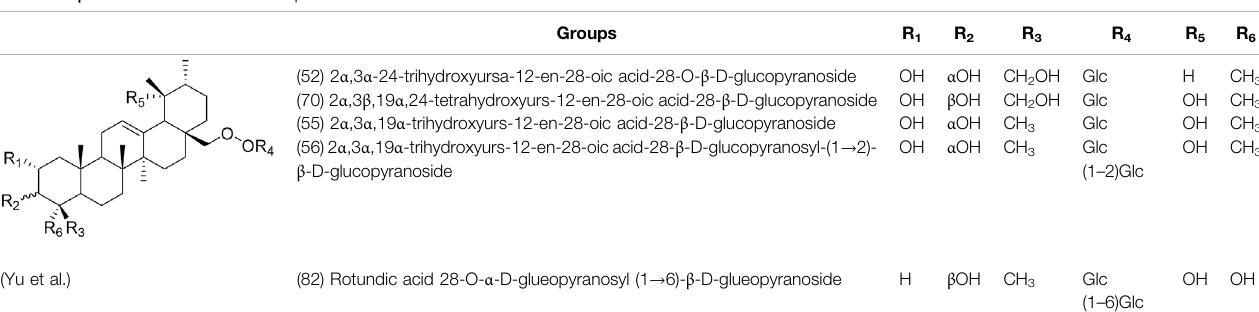
TABLE 6 | Chemical structures of triterpenes isolated from PVL ─ Part